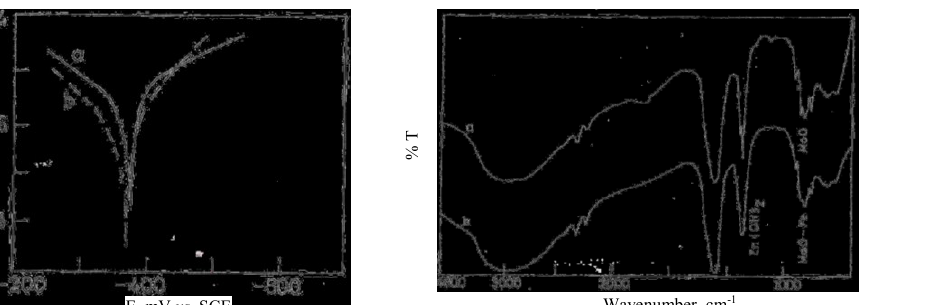
Figure 1. Polarization curves of carbon steel immersed in various test solutio, (a)Cl - 120 ppm, (b) Cl - 120 ppm + SM 50 ppm + Zn 2+ 50 ppm.